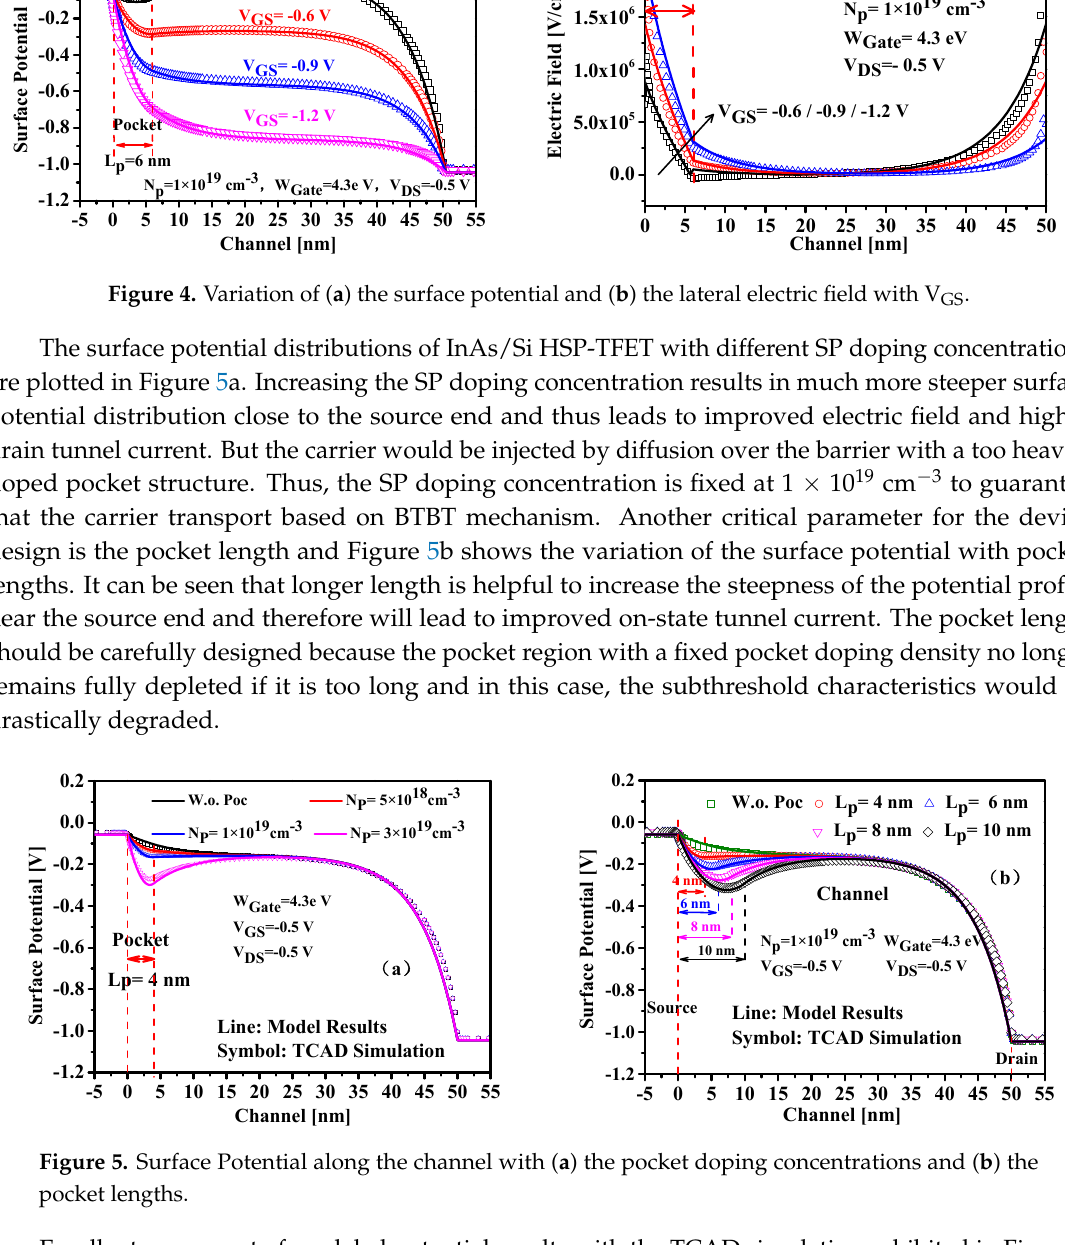
E C W t,minΔEC Figure 6. Shortest tunneling distance versus gate voltage. The pocket doping density for HSP-TFET is 1 × 10 19 cm − 3 . The gate work function is 4.7 eV and the drain bias is 0.5 V. Figure 7 shows the transfer characteristics calculated from our model for different pocket doping concentrations and pocket lengths. It is obvious that good agreement is obtained between the model results and the numerical simulations in the on-state where the BTBT current dominates. The large deviation in the off-state results from the neglect of the SRH thermal generation which dominates the off-state leakage current. Due to the heavily doped pocket structure, the InAs/Si HSP-TFET exhibits improved drain tunneling current compared with that of InAs/Si HTFETs without SP. This can be understood from Figure 5 in which the HSP-TFET shows a potential minimum near the source-to-